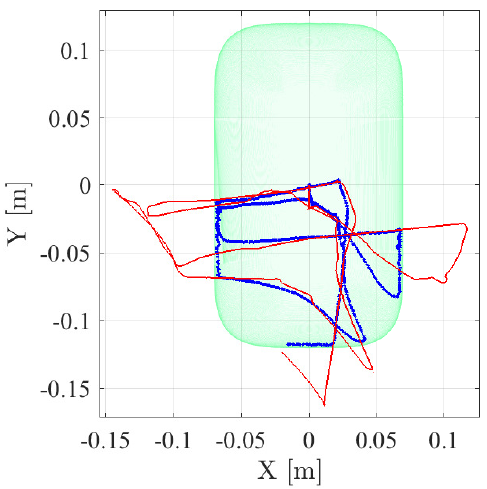
Figure 18. The 2D trajectory performance for the fourth experiment, showing the simultaneous teleoperation of both robots (see the video at https://media.upv.es/player/?id=29330720-8a8b-11ec- 97cd-ab744f931636 (accessed on 26 April 2022) [84]): 2D allowed workpiece region in green; trajectory followed by the user reference in thin red line; and trajectory followed by the STR tool in thick blue